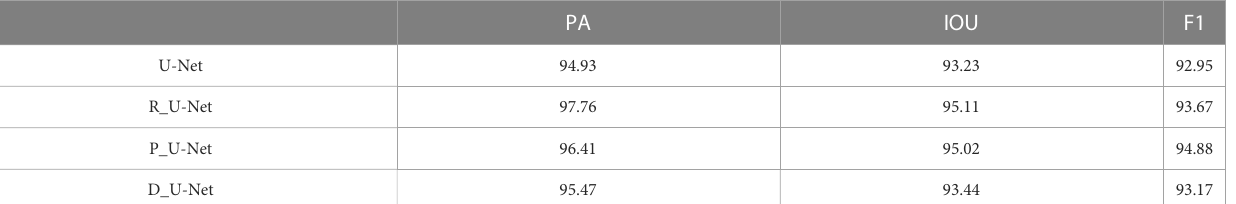
TABLE 2 Ablation experiments.